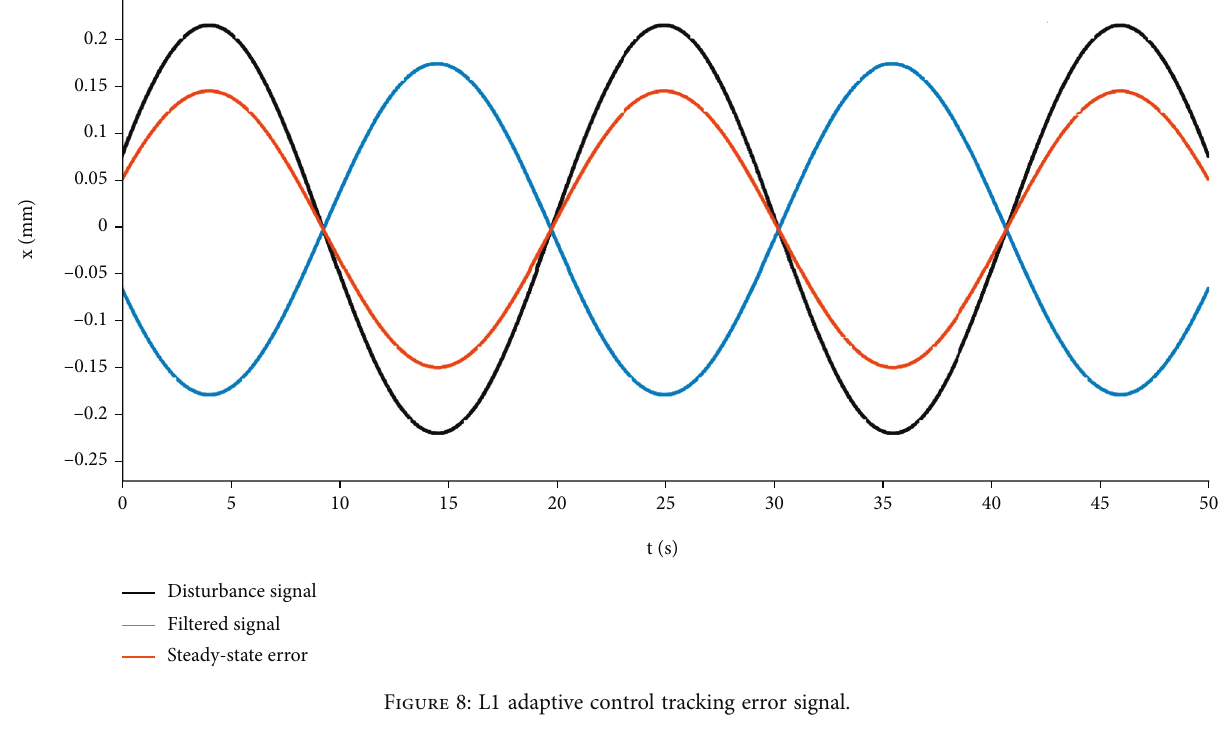
Figure 8: L1 adaptive control tracking error signal.